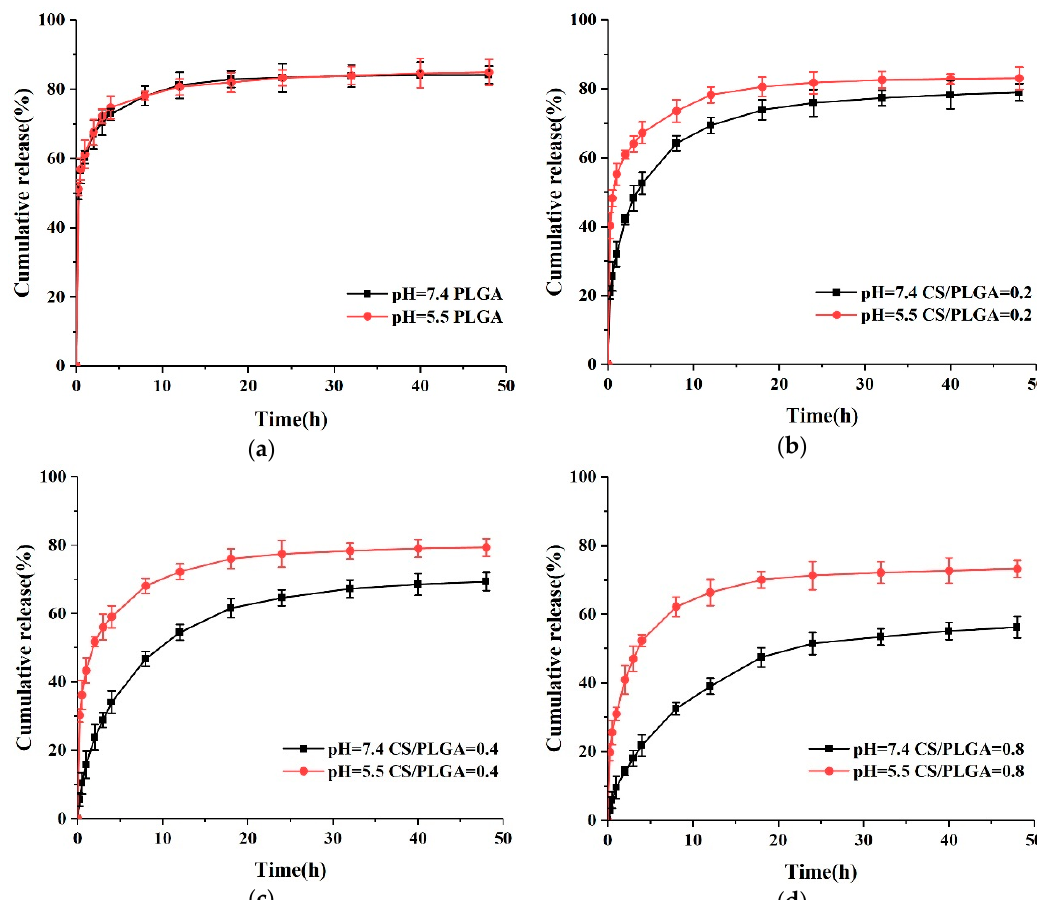
Figure 7. In vitro release of PTX from NPs at pH 7.4 and pH 5.5: ( a ) PLGA; ( b ) CS/PLGA = 0.2; ( c ) CS/PLGA = 0.4; and ( d ) CS/PLGA = 0.8.